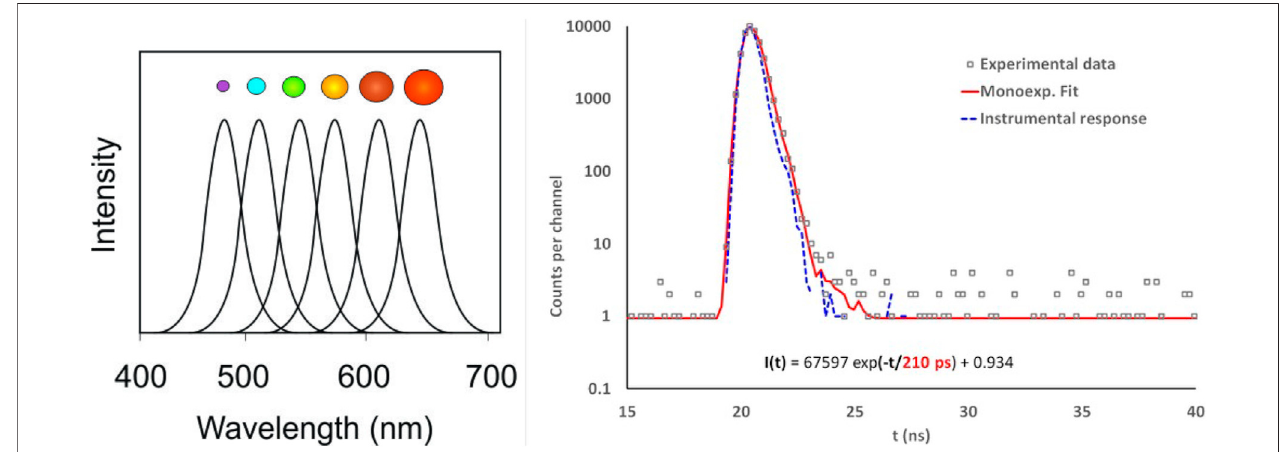
FIGURE 1 | Left: Emission spectrum as a function of nanocrystal size (from [22]). Right: decay time spectra of ZnO(Ga) under irradiation by X-rays (from